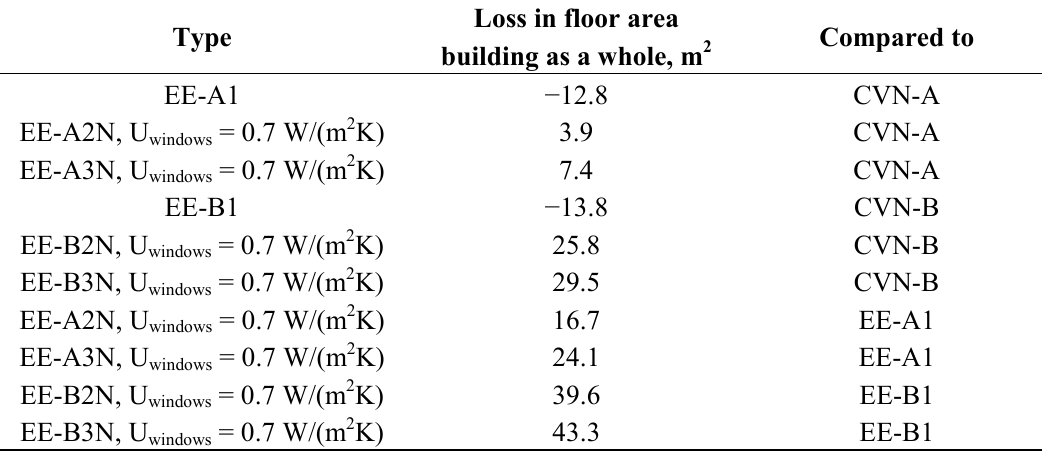
Table A1. Loss in floor area between conventional and energy-efficient building and between energy-efficient building with different technologies, year